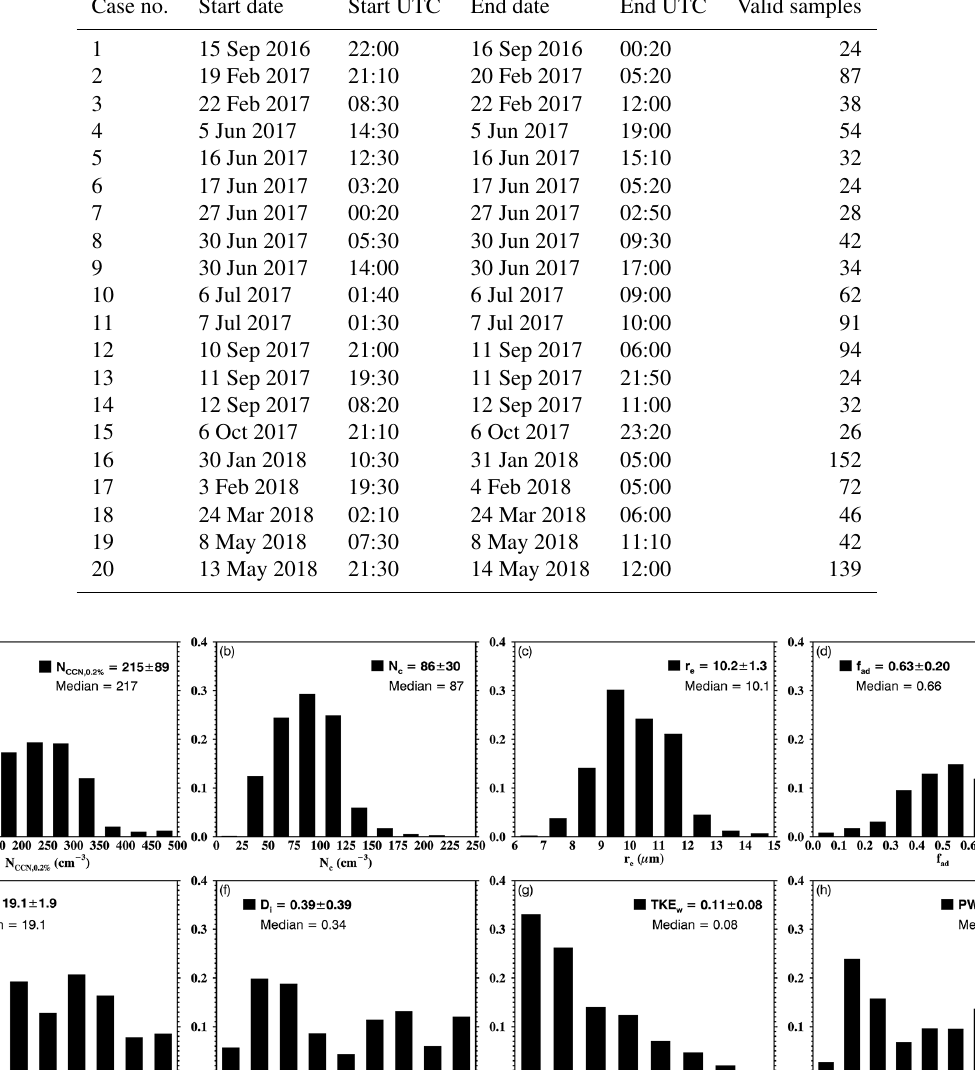
Table 1. Dates and time periods of selected non-precipitating MBL cloud periods. Case no.